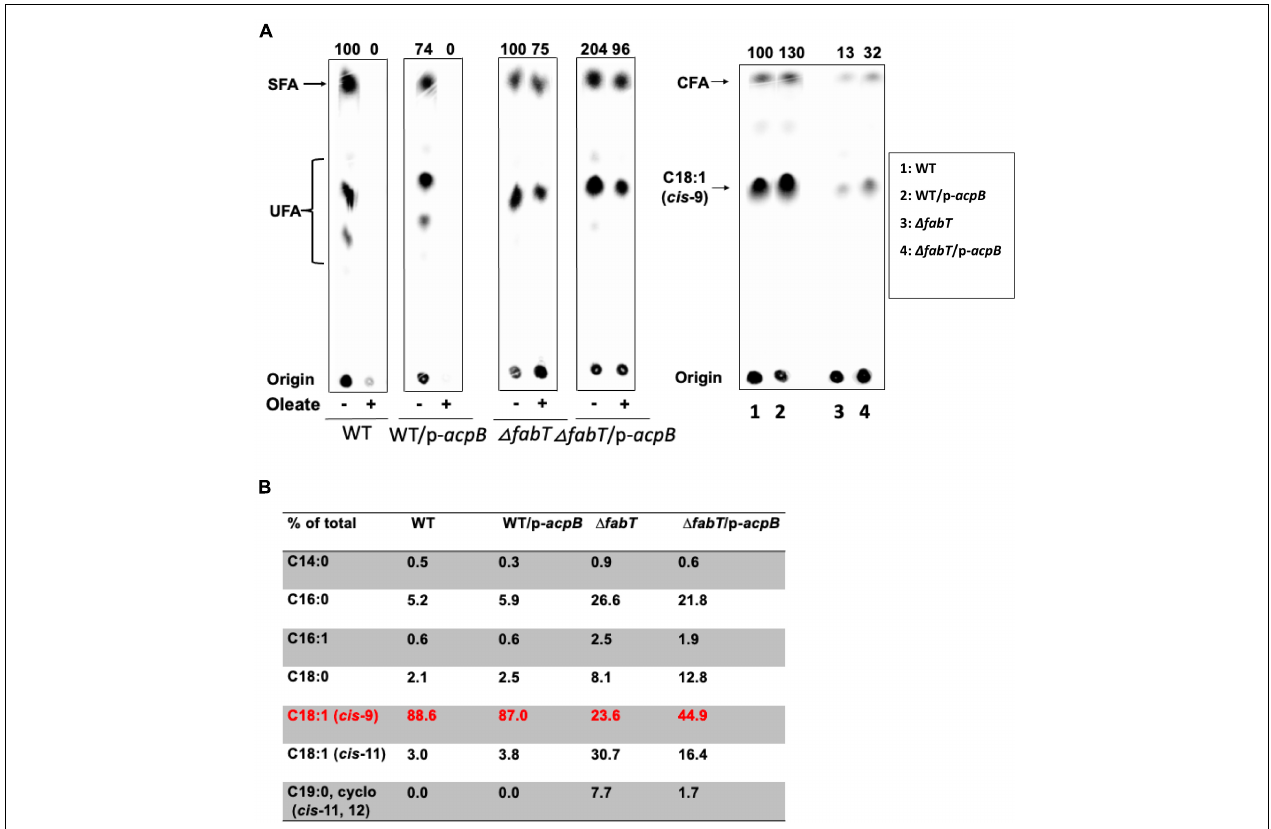
FIGURE 7 | The regulatory function of E. faecalis AcpB for fatty acid biosynthesis relies on FabT. (A) De novo fatty acid biosynthesis of the E. faecalis wild-type strain overexpressing AcpB and (cid:49) fabT strain overexpressing AcpB. Incorporation of [ 14 C]oleic acid into the cell membrane phospholipids of the E. faecalis AcpB overexpression strain. (B) GC-MS analysis for proportion of oleic acid incorporation into the cell membrane phospholipids of the E. faecalis AcpB overexpression strain. For panels (A) , the lanes of cells with stearic acid at the right of each group were deleted since they were unrelated to this study. (B) , Two lanes for the (cid:49) acpB:cat (ZL318) strain and its AcpB overexpression derivative at the right of (cid:49) fabT group were deleted due to the FabT* mutation of this